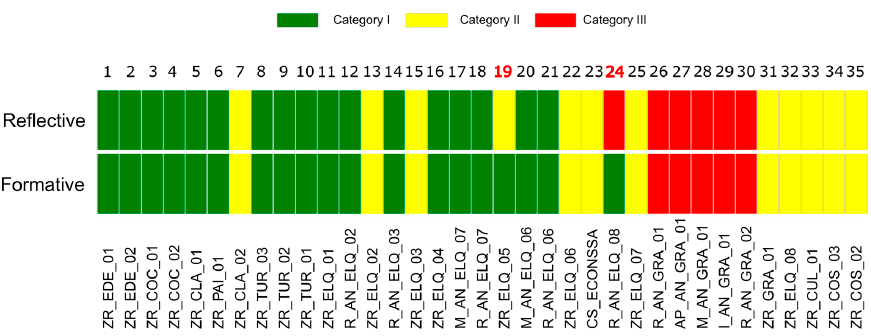
Figure 6. Cluster-analysis-based contextual vulnerability category as a function of SEM PLSPM measurement model type. Node ID numbers (above) and names (below) as in Figure 4. Red numbers reflect category differences in the corresponding node.